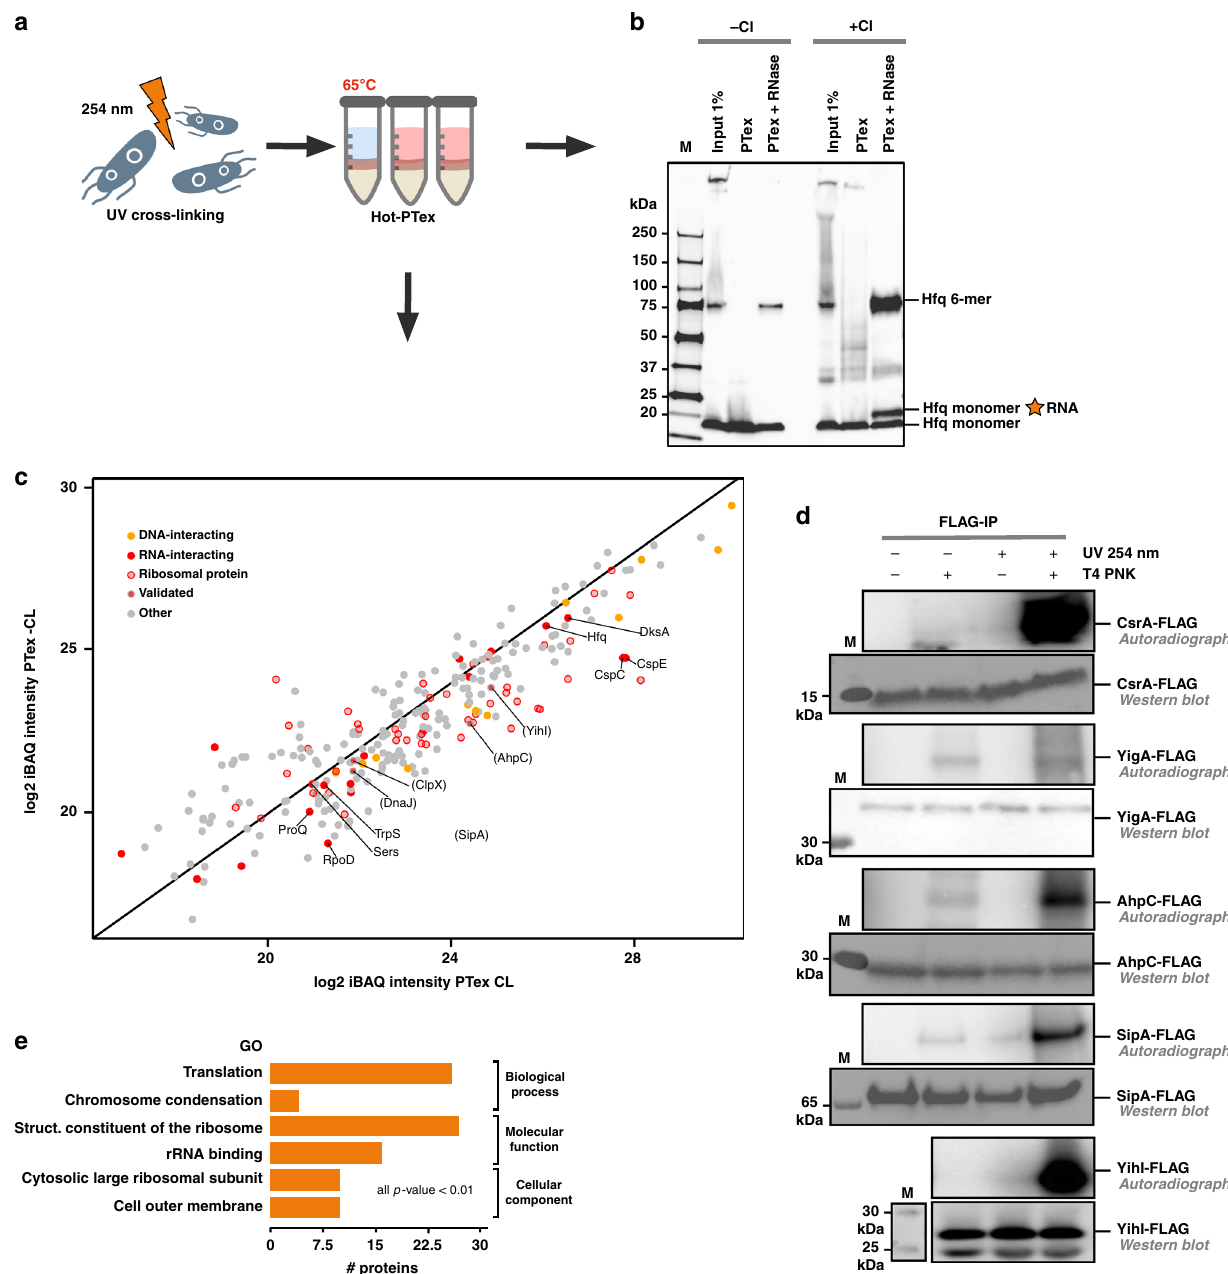
Fig. 7 PTex recovers bacterial RNPs. a Salmonella Typhimurium SL1344 Hfq-FLAG was UV-cross-linked and HOT-PTex was performed to purify bacterial RNPs. b Western blot using an anti-FLAG antibody demonstrates recovery of Hfq monomers linked to RNA. Note that the physiologically active